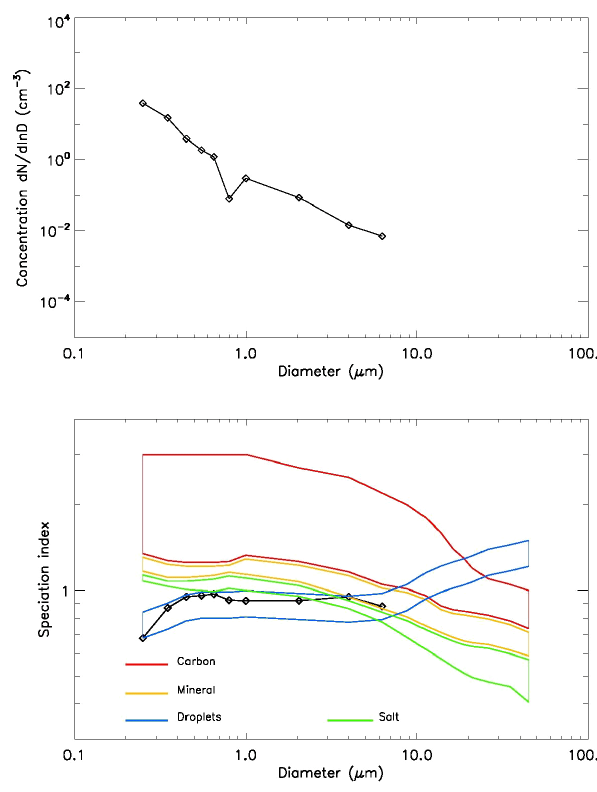
Figure 20. Example of measurements inside a haze or thin cloud at an altitude of 1.2km during a flight under meteorological balloon from Reykjavik (Iceland) on 7 November 2013 at 12:30UT; upper panel: size distribution; lower panel: typology, the LOAC data are in black dots. The LOAC uncertainties are ± 20% for the higher concentration and ± 40% for the lower concentrations.